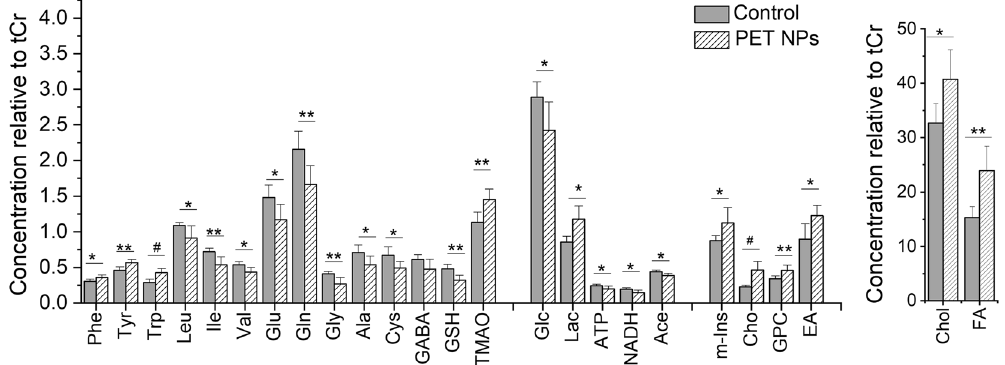
Figure 6. Effect of PET NPs treatment on the metabolic profile of intact zebrafish embryos. Zebrafish embryos (72 hpf) were exposed to 100 ppm PET NPs for 24 h. Concentrations of metabolites relative to total creatine (tCr) are shown. For statistical analysis, one-way ANOVA with a Tukey post-hoc correction for multiple comparisons were performed using OriginPro v. 8 (Northampton, MA, USA). Values shown are the mean ± standard deviation (n = 6). The statistically significant differences in metabolites between PET NPs treated and control group obtained by ANOVA analysis are indicated by # p < 0.001, ** p < 0.01 and * p < 0.05. Abbreviations: Phe = phenylalanine; Trp = tryptophan; Tyr = tyrosine; Leu = leucine, Ile = isoleucine; Val = valine; Glu = glutamate; Gln = glutamine; Gly = glycine; Ala = alanine; Cys = cysteine; GABA = g-aminobutyric acid; GSH = glutathione; TMAO = trimethylamine N-oxide; Glc = glucose; Lac = lactate; ATP = adenosine triphosphate; NADH = nicotinamide adenine dinucleotide; m-Ins = myo-inositol; Cho = choline; GPC = glycerophosphocholine; Chol = cholesterol; FA = fatty acids.